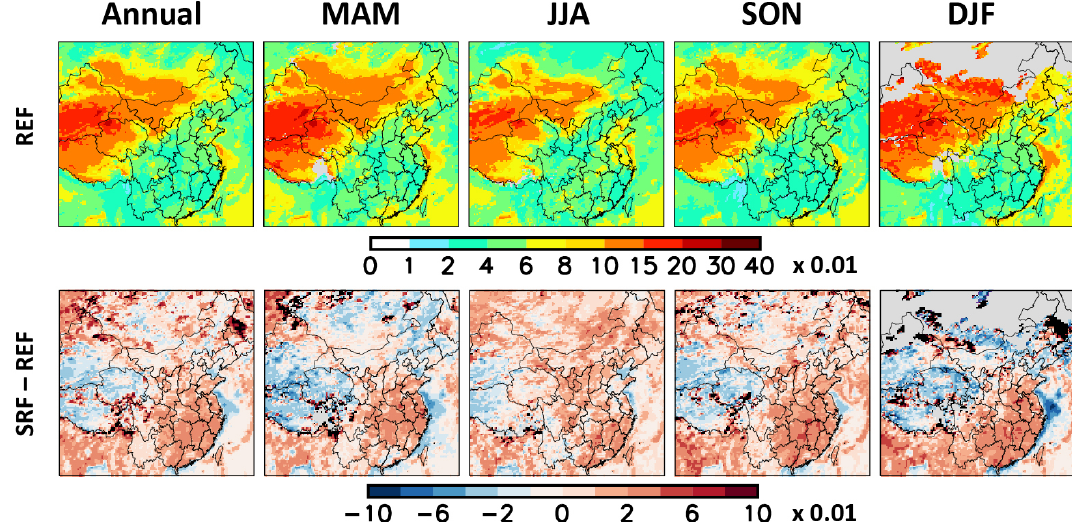
Figure 4. First row: surface reflectance in case REF = POMINO (MODIS BRF data) at annual and seasonal scales. Second row: surface reflectance in case SRF (OMLER v1 albedo) minus reflectance in case REF (MODIS BRF). Provincial boundaries of China are shown. Data are sampled from valid pixels of case REF. Values outside the upper (lower) bound of color intervals are shown in black (purple). Missing values are shown in grey. Color intervals are nonlinear to better present the data range; an interval without labeling represents the mean of the adjacent two